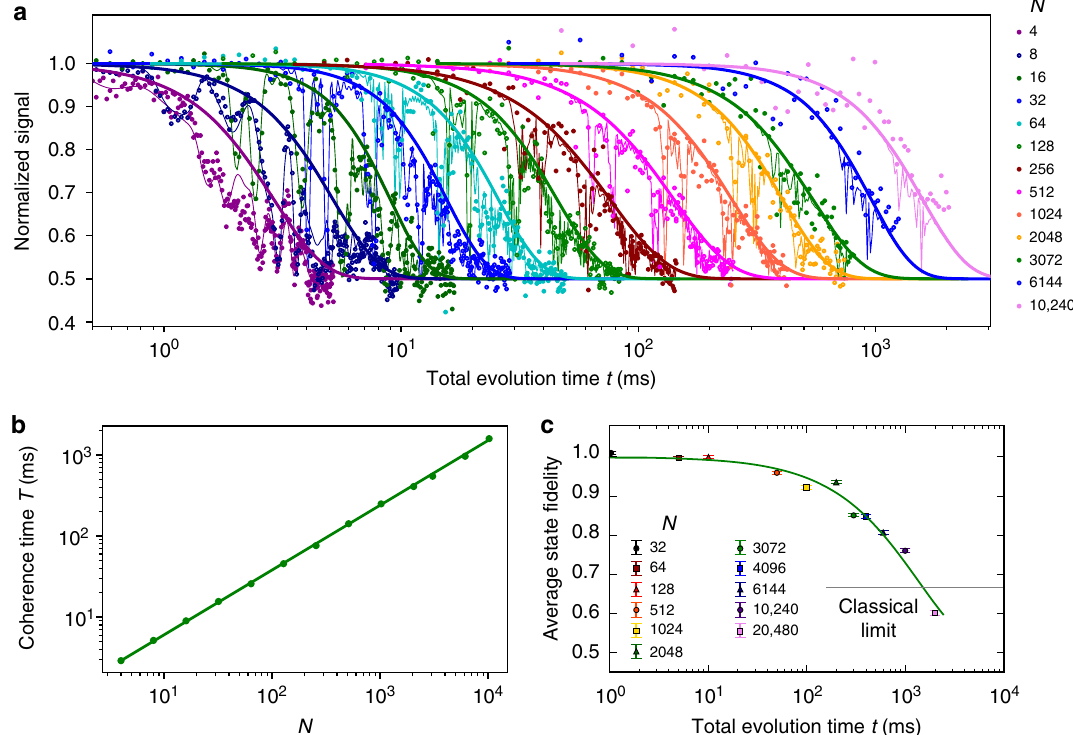
Fig. 5 Protecting quantum states with tailored decoupling sequences. a Normalized signal under dynamical decoupling with the number of pulses varying from N = 4 to N = 10,240. The electron is initialized and readout along x . The thin lines are fi ts to equation (4), which takes into account the six identi fi ed (cid:3) (cid:4) 13 C – 13 C pairs. We use the extracted amplitudes A to re-normalize the signal. Thick lines are the extracted envelops 0 : 5 þ 0 : 5 (cid:4) e (cid:2)ð t = T Þ n with T and n obtained from the fi ts. See Supplementary Fig. 6 for the obtained values n . b Scaling of the obtained coherence time T as function of the number of pulses (cid:4) ð N = 4 Þ η , where T N = 4. We fi nd η = 0.799(2). c The (error bars are <5%). The solid line is a fi t to the power function T N ¼ N = 4 is the coherence time for 4 average state fi delity obtained for the six cardinal states (Supplementary Fig. 8). Unlike in a , the signal is shown without any renormalization. The number of pulses N is chosen to maximize the obtained signal at the given total evolution time while avoiding interactions with the 13 C environment. The solid fi delity marks the classical limit for storing quantum states. The two curves cross at t = green line is a fi t to an exponential decay. The horizontal line at 2 3 1.46 s demonstrating the protection of arbitrary quantum states well beyond a second. All error bars are one statistical